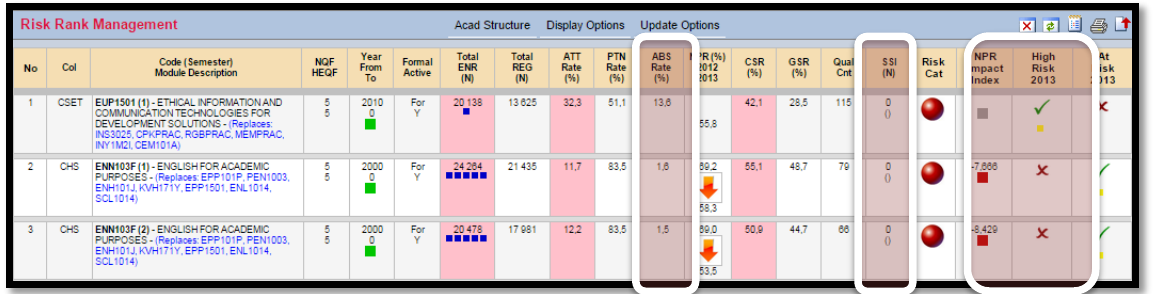
Figure 12 . Excerpts risk management